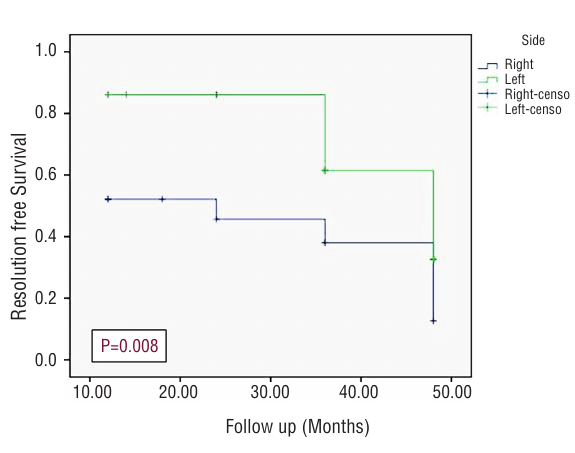
figure 5 - Kaplan-Meier curve Showing Incidence of Resolution Stratifying By Gender.